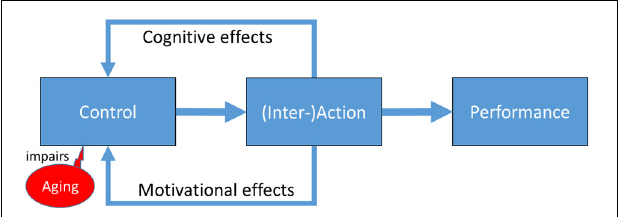
FIGURE 1 | Cognitive control as independent and dependent